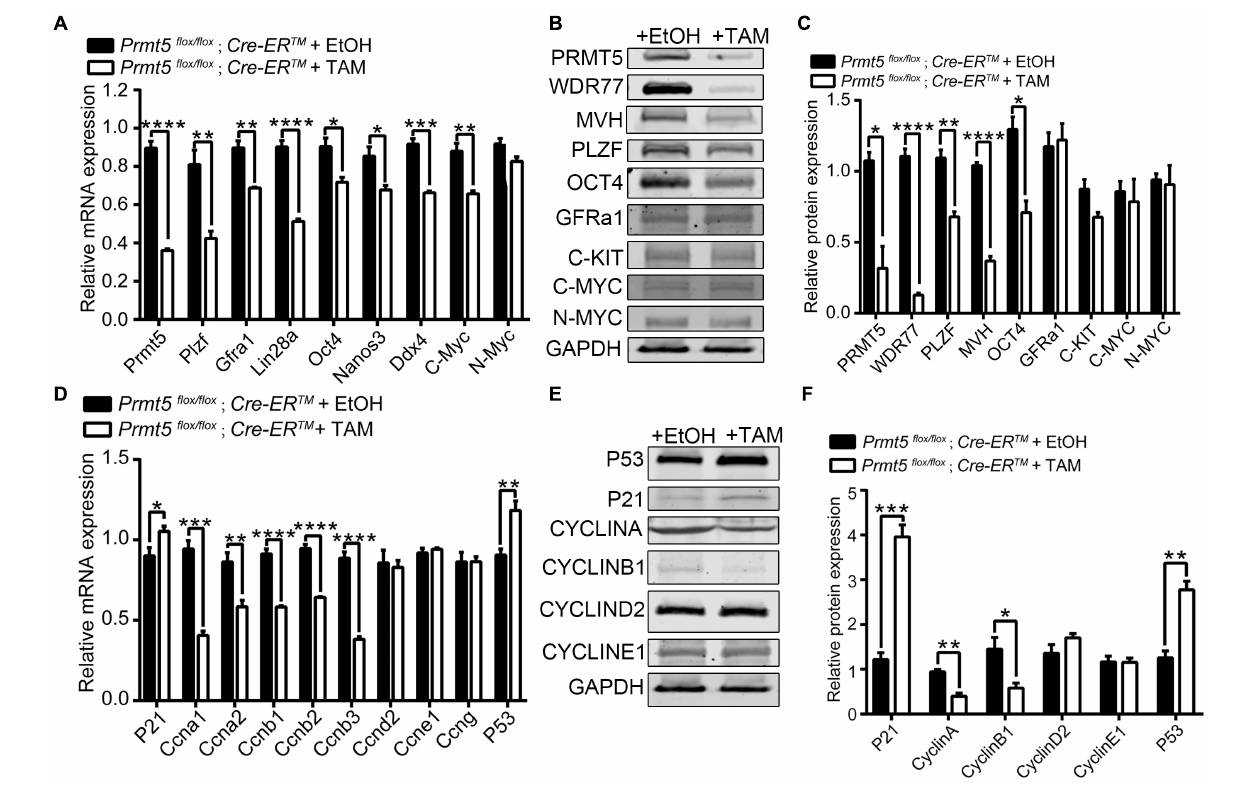
FIGURE 5 | Differentially expressed genes in Prmt5- deficient spermatogonial stem cells. The expression of genes related to self-renewal and proliferation was analyzed by real-time PCR (A) and western blotting (B) in Prmt5 flox / flox ;Cre-ER TM SSCs treated with ethanol or 1 µ M tamoxifen. The quantitative results of western blot analysis (C) . The expression of cell cycle-associated genes was analyzed by real-time PCR (D) and western blot (E) . The quantitative results of western blot analysis (F) . GAPDH was used as a loading control, and the protein values were normalized. Error bars represent the SEM of triplicate results. * P < 0.05, ** P < 0.005, *** P < 0.0005, **** P < 0.0005 indicates a significant difference ( t